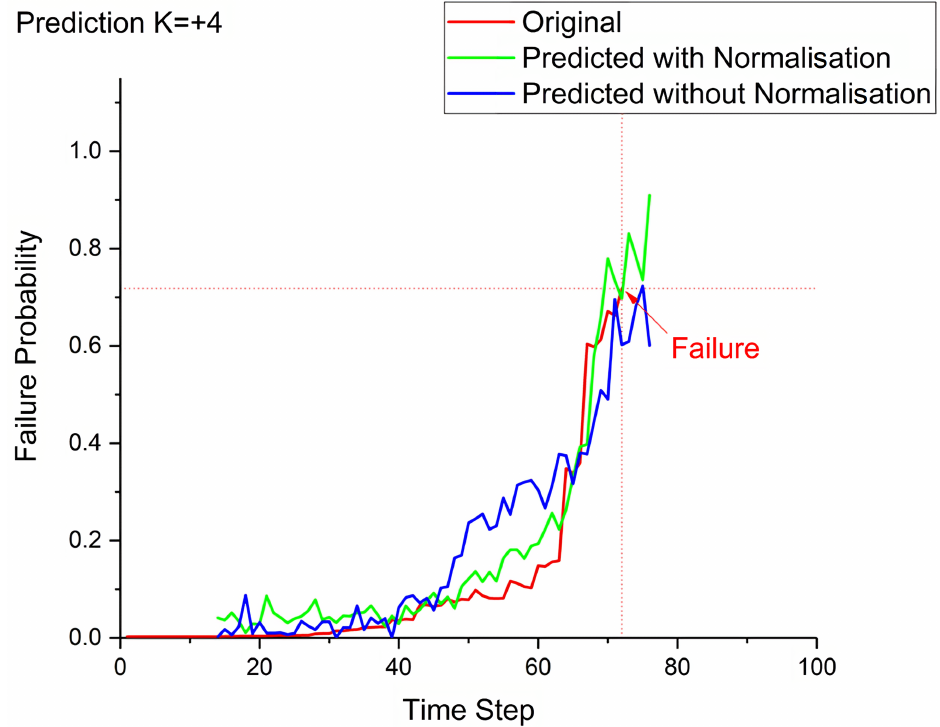
Figure 9. Failure prediction at T +